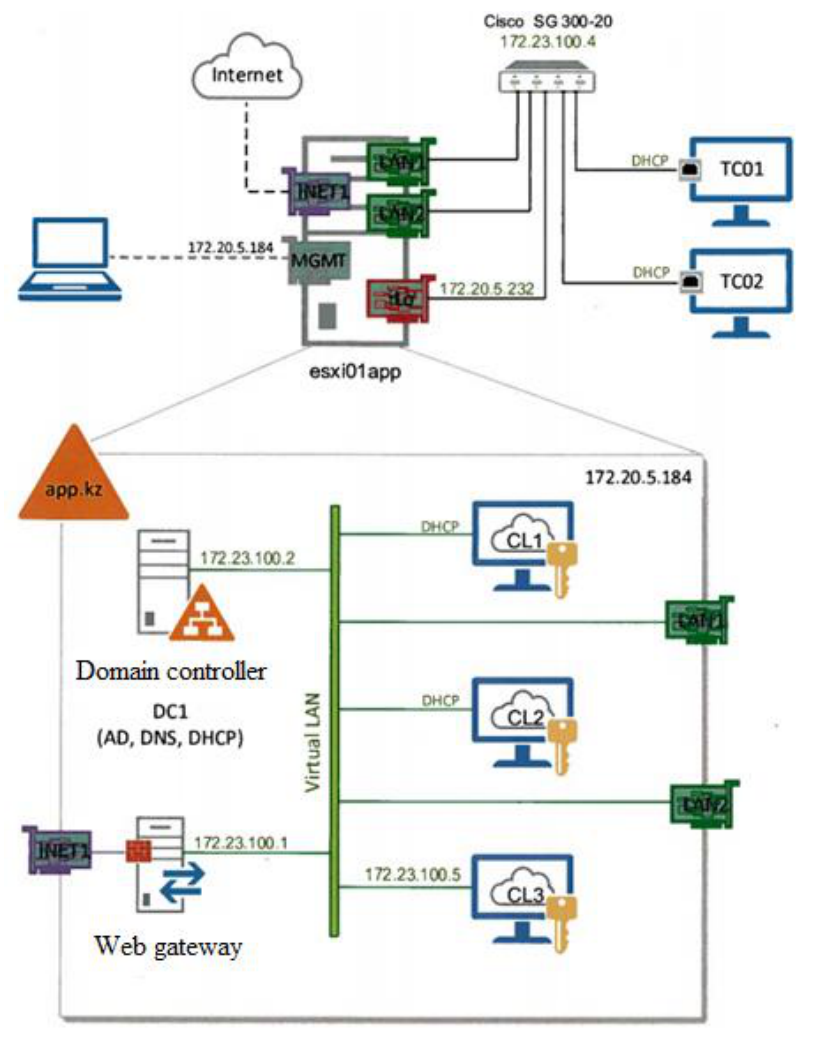
Figure 1 . Physical and logical diagrams of the table